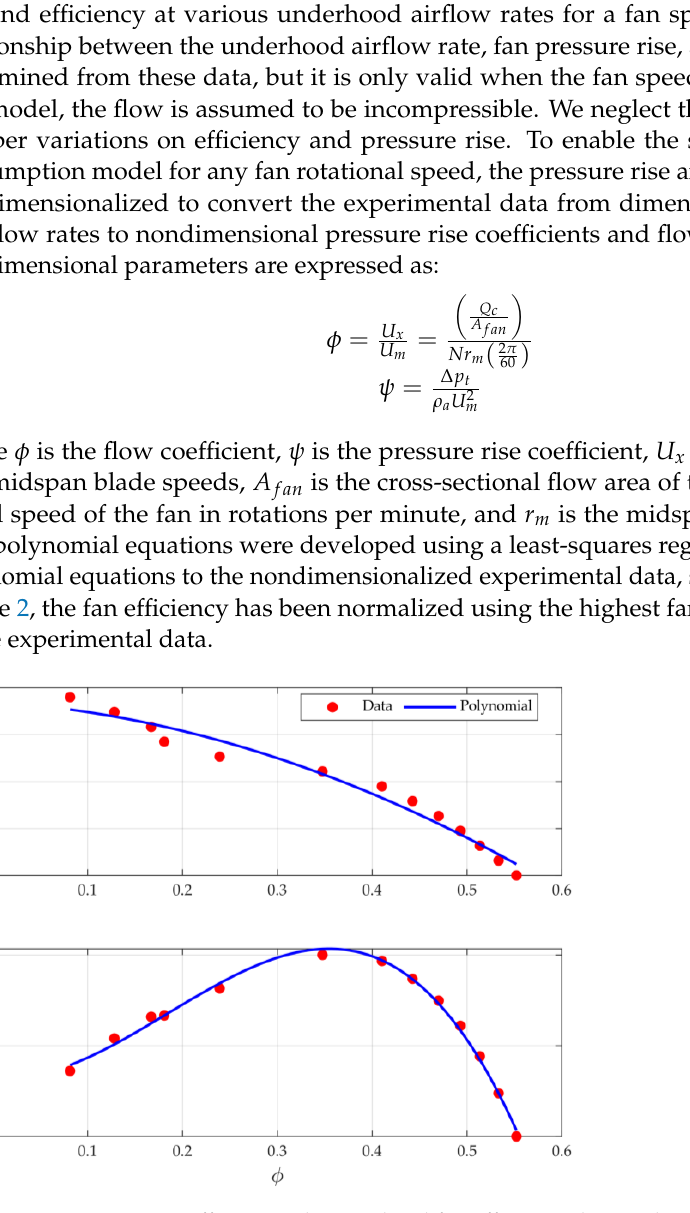
Figure 2. Pressure rise coefficient and normalized fan efficiency data with polynomial fits.